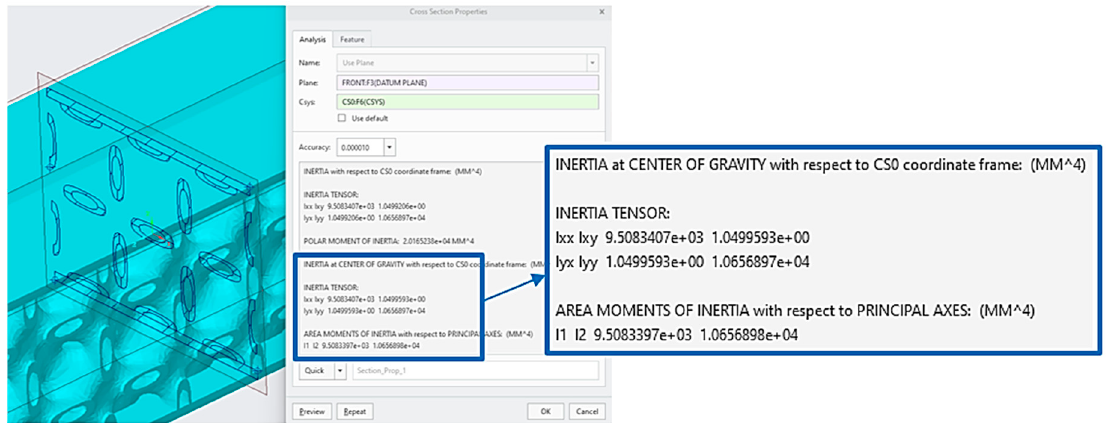
Figure 7. Moment of inertia specification.